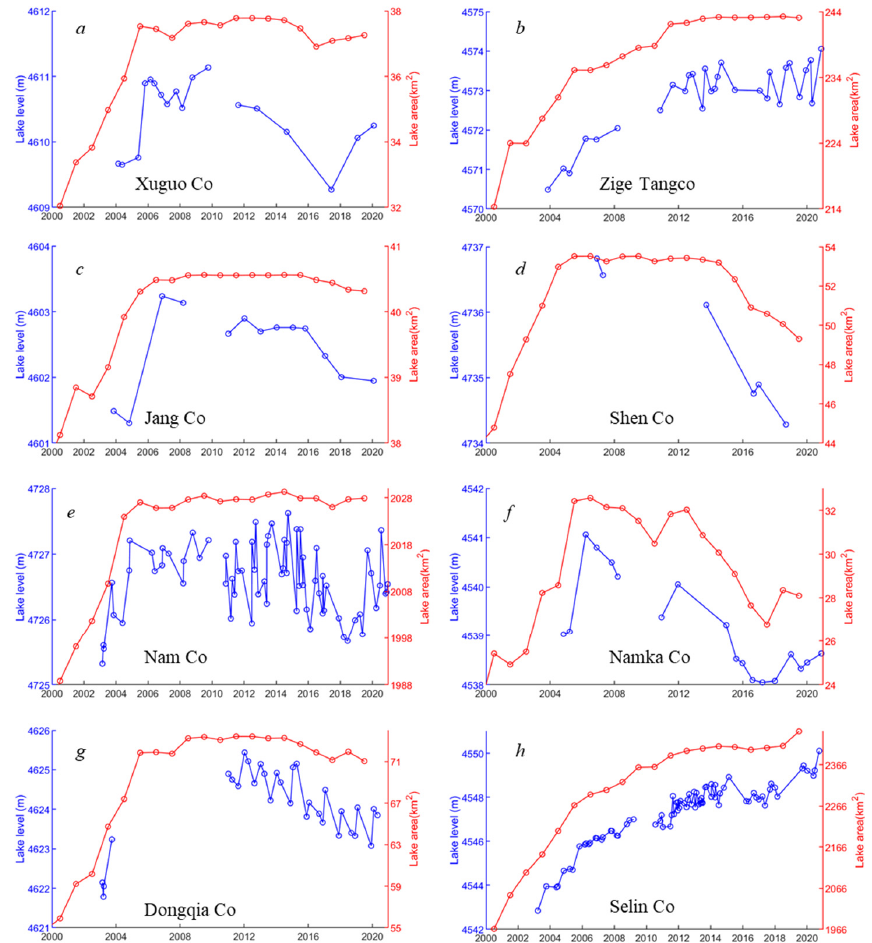
Figure 5. ( a – h ) Time series of lake area and altimeter-derived water level of eight lakes in 2000–